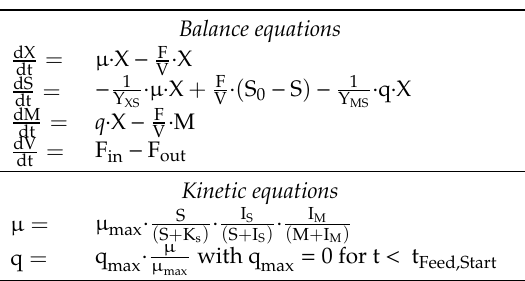
Table A15. Model equations for NMPC. Model